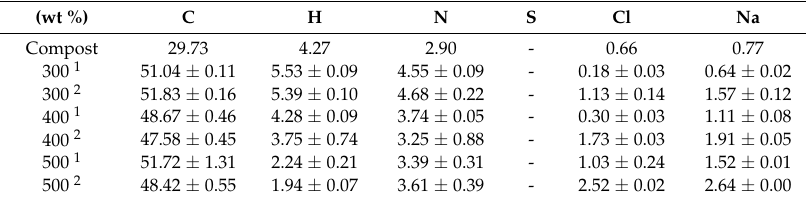
Table 2. Element and salt content analysis of biochar at various pyrolysis